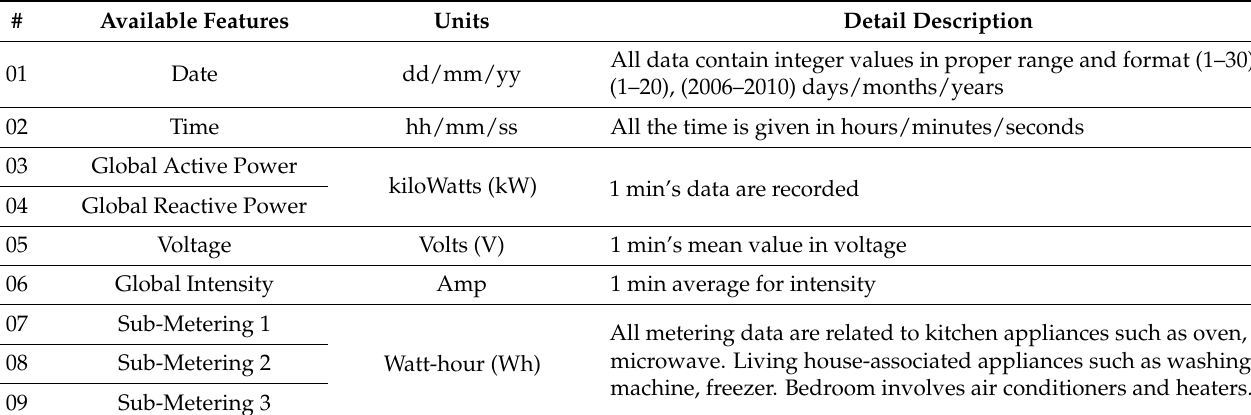
Table 2. Detailed description of the IHEPC residential dataset with features and